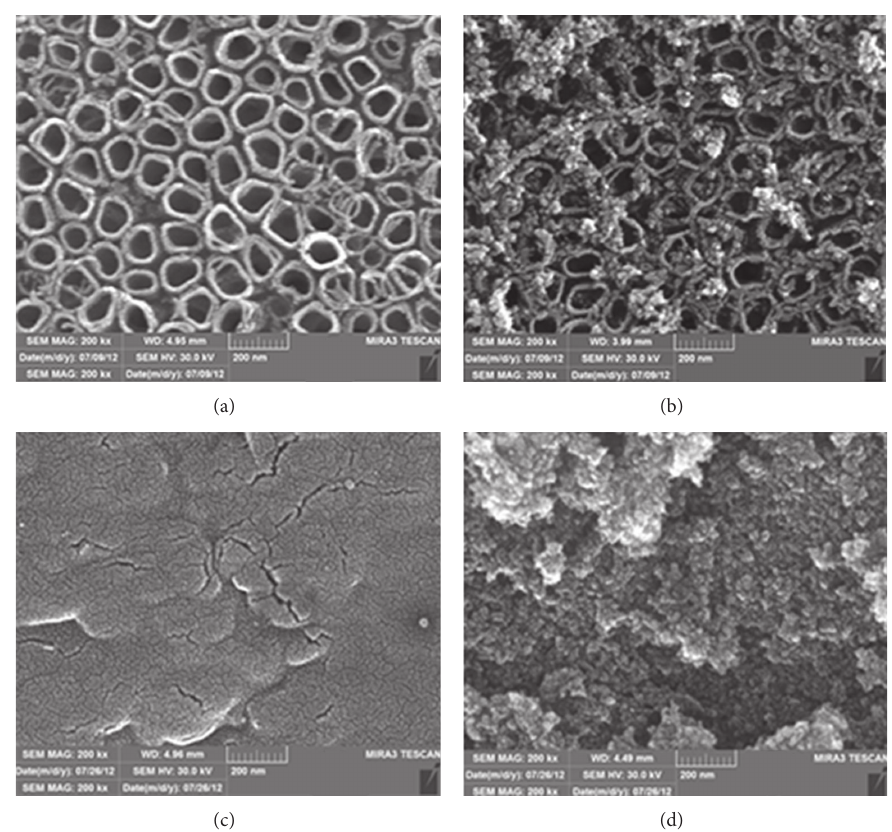
Figure 1: SEM images of the anodes utilised: nanotubular TiO 2 (NT) (a); nanotubular TiO 2 decorated (NTD) (b); compact oxides (OC) (c); compact oxide decorated (OCD) (d).